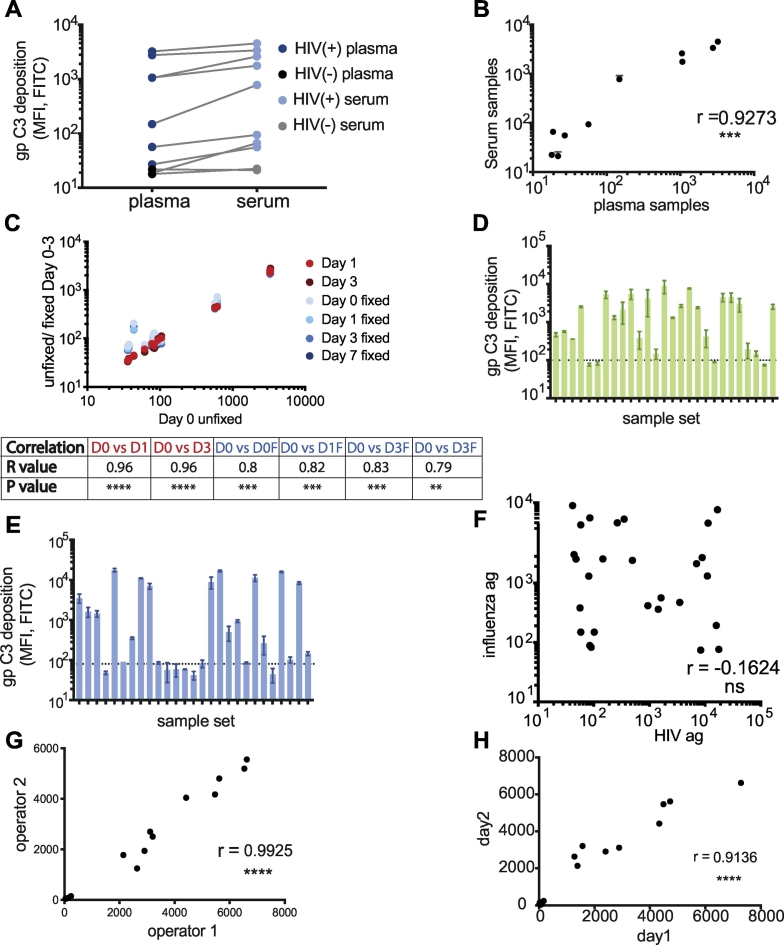
Assessment of the versatility and reproducibility of the ADCD assay. A-C: The ADCD assay was tested for versatility by comparing plasma and serum samples prepared from the same whole blood draws from 8 HIV-positive and 2 HIV-negative individuals. These samples were tested using the standard assay protocol, HIV gp120-coupled beads, a 1:10 sample dilution, and guinea pig complement. Shown are (A) the individual C3 deposition results for each test sample and (B) the correlation of C3 deposition results for plasma versus serum samples from each subject. Additional assay plates were set up in parallel using the same plasma samples, the beads were either resuspended in PBS or fixed with 4% PFA at the end of the assay, and then the beads were acquired on a flow cytometer on the day of the assay (Day 0) or up to 7 days later. (C) The correlation of C3 deposition results for each assay condition and time point are shown versus unfixed beads acquired on Day 0. D–F: A sample set of 27 HIV-positive samples was tested against an (D) influenza HA antigen (H1N1, California, 2009) and (E) HIV gp120 antigen (YU2). Bars indicate mean ± SD of technical replicates, and dotted line represents assay background (PBS control). The correlation of C3 deposition results for the sample set for HIV gp120 and influenza HA antigens is shown in (F). G: Two independent operators tested 10 HIV-positive and 2 HIV-negative plasma samples in the ADCD assay using HIV gp120-coupled beads. The correlation of C3 deposition results obtained between operators is shown in (G). H: A single operator tested 9 HIV-positive and 2 HIV-negative plasma samples in the ADCD assay using HIV gp120-coupled beads twice on separate days. The correlation of C3 deposition results obtained between the two assay runs is shown in (H). For all analyses, a one-way ANOVA was used to compared differences across >2 groups, a paired t-test was used to test differences across 2 groups, and correlations were assessed using a two-tailed Spearman correlation: ***p < 0.0005, ****p < 0.0001.